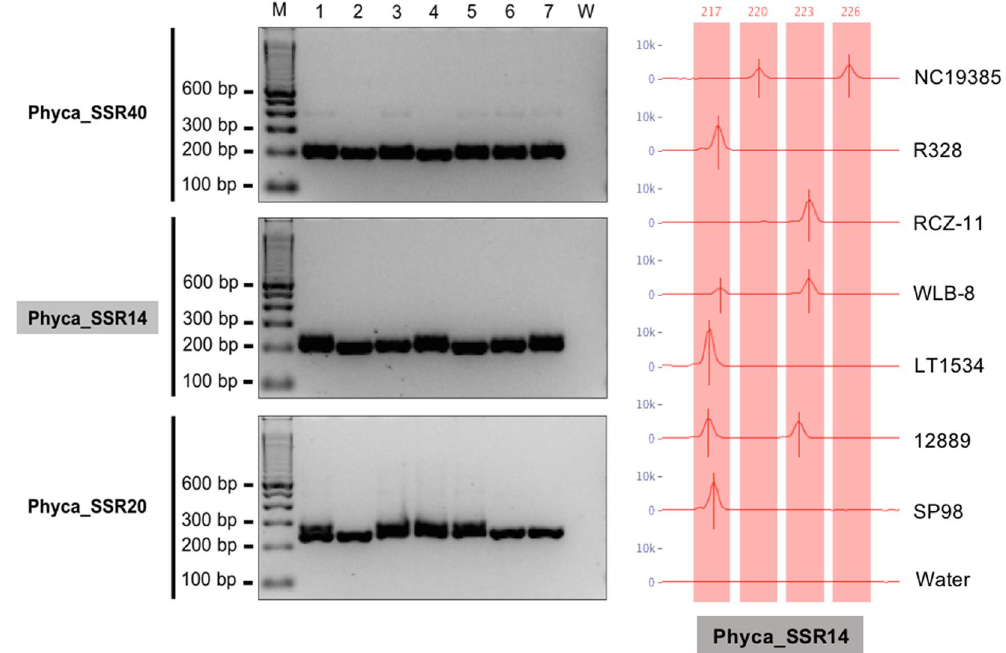
Figure 1. Amplification profile from 7 P . capsici isolates using the Phyca_SSR40, Phyca_SSR14, and Phyca_ SSR20 primers. M: 100 bp marker, 1: NC19385, 2: R328, 3: RCZ-11, 4: WLB-8, 5: LT1534, 6: 12889, 7: SP98, and W: water. PCR products were resolved in 4% agarose gel. Fragment analysis profile for Phyca_SSR14 across the 7 P. capsici isolates, ordered as in the gel. The gels are cropped from different parts of different gels. Full-length gels are included in supplementary Figs S6, S7, and